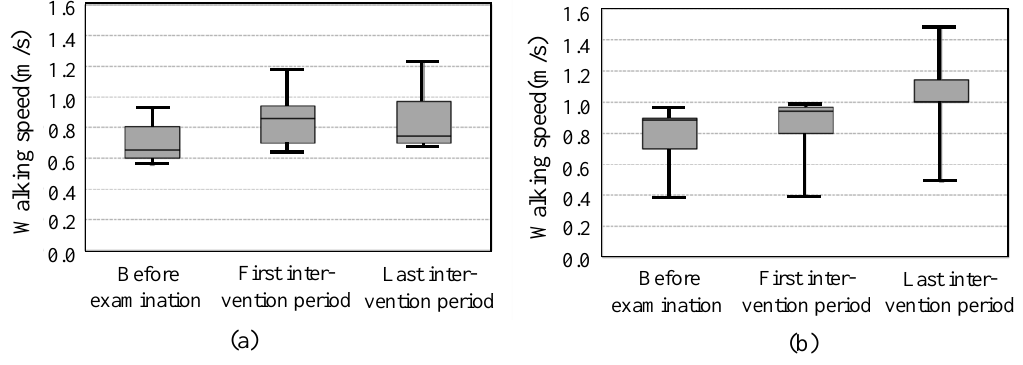
Figure 5. Walking speed during 5-m walking test. ( a ) Group A; ( b ) Group B Figure 8. Walking speed during 5-m walking test. ( a ) Group A; ( b ) Group